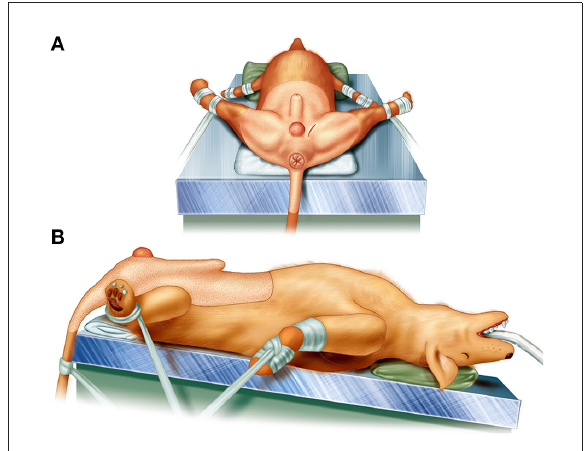
FIGURE1 Illustrations of patient’s position for perineal herniorrhaphy using the pedunculated tunica vaginalis communis. The patient was held in the Trendelenburg position at the edge of the operating table, the hind limbs were pulled sideways, and the tail was fixed so as to hang down. (A) The caudal view of the position and (B) the left side view.